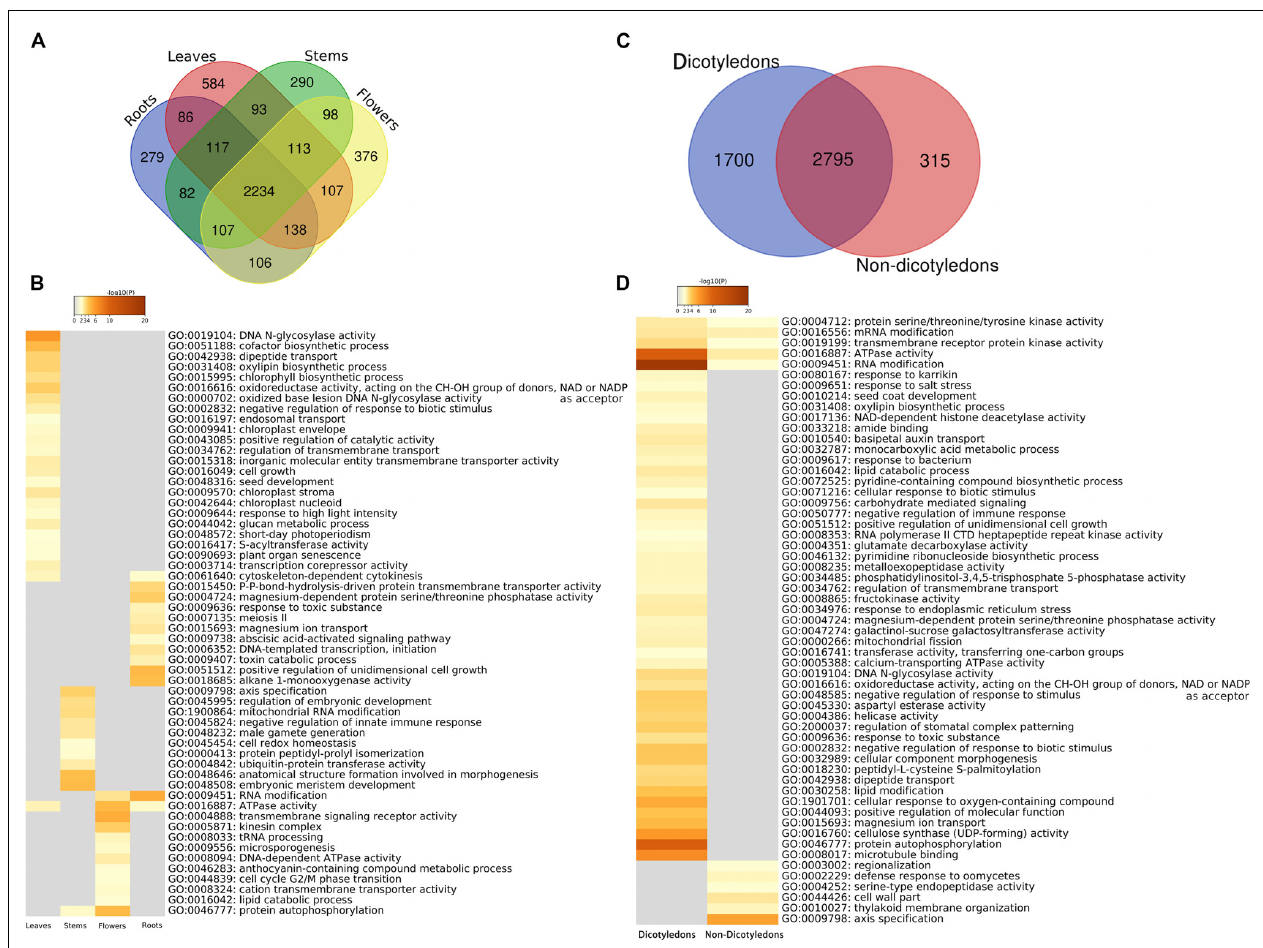
FIGURE 5 | Organ-specific and dicotyledon-/non-dicotyledon-specific genes and functional enrichment analyses results. (A) Venn diagram of the annotated gene numbers in the leaves, roots, stems and flowers. (B) Heat map of P -values of significant enriched functional categories on each organ. The color key from gray to brown indicates large to small P -values. (C) Venn diagram of the annotated gene numbers in dicotyledons and non-dicotyledons. (D) Heat maps of P -values of significant enriched functional categories on dicotyledons or non-dicotyledons. The color key from gray to brown indicates large to small P